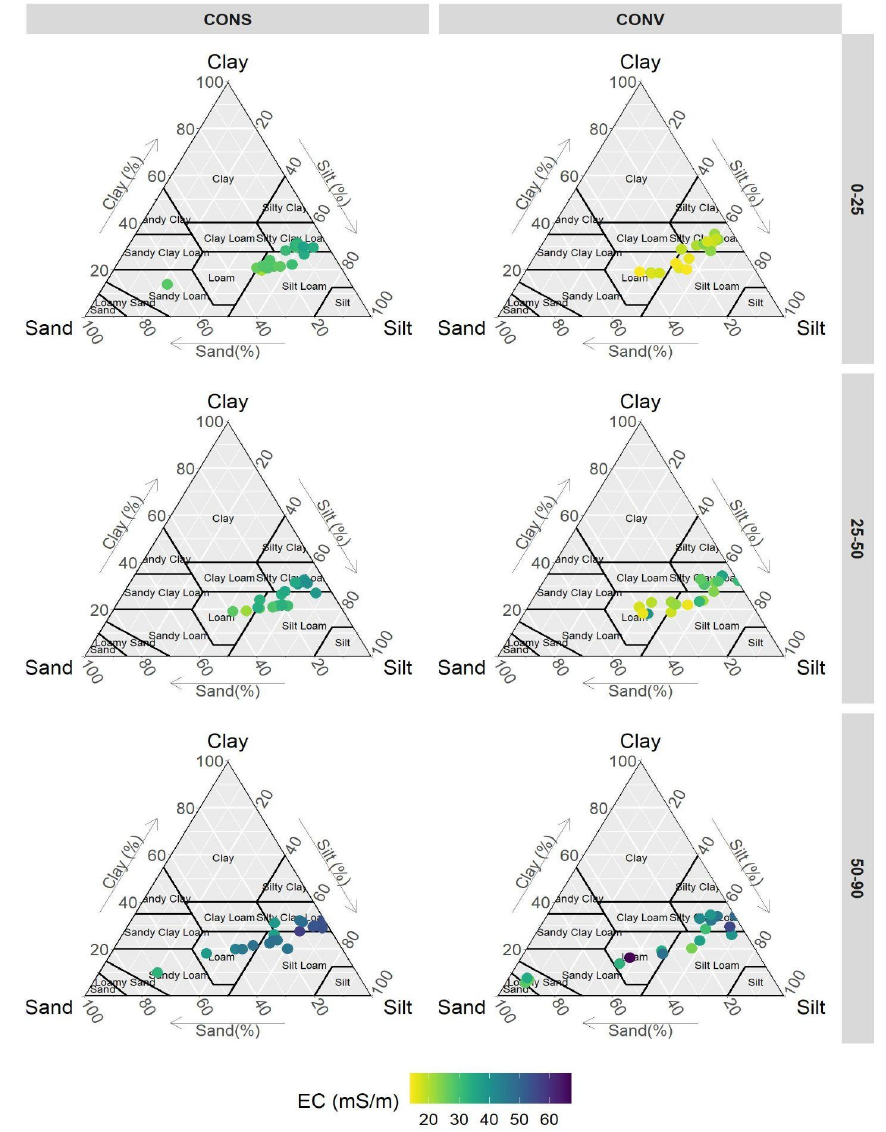
Figure 9. Relations between textural classes and inverted EC measured on 19 December 2017.